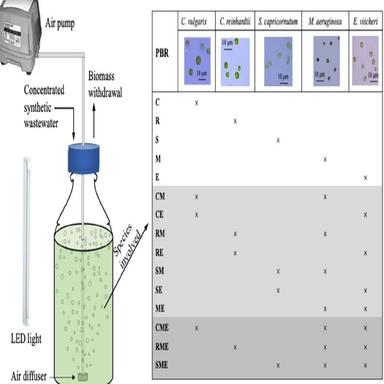
PBR configuration and species of monocultures (in white) and mixed cultures (two species in light grey and three species in dark grey).